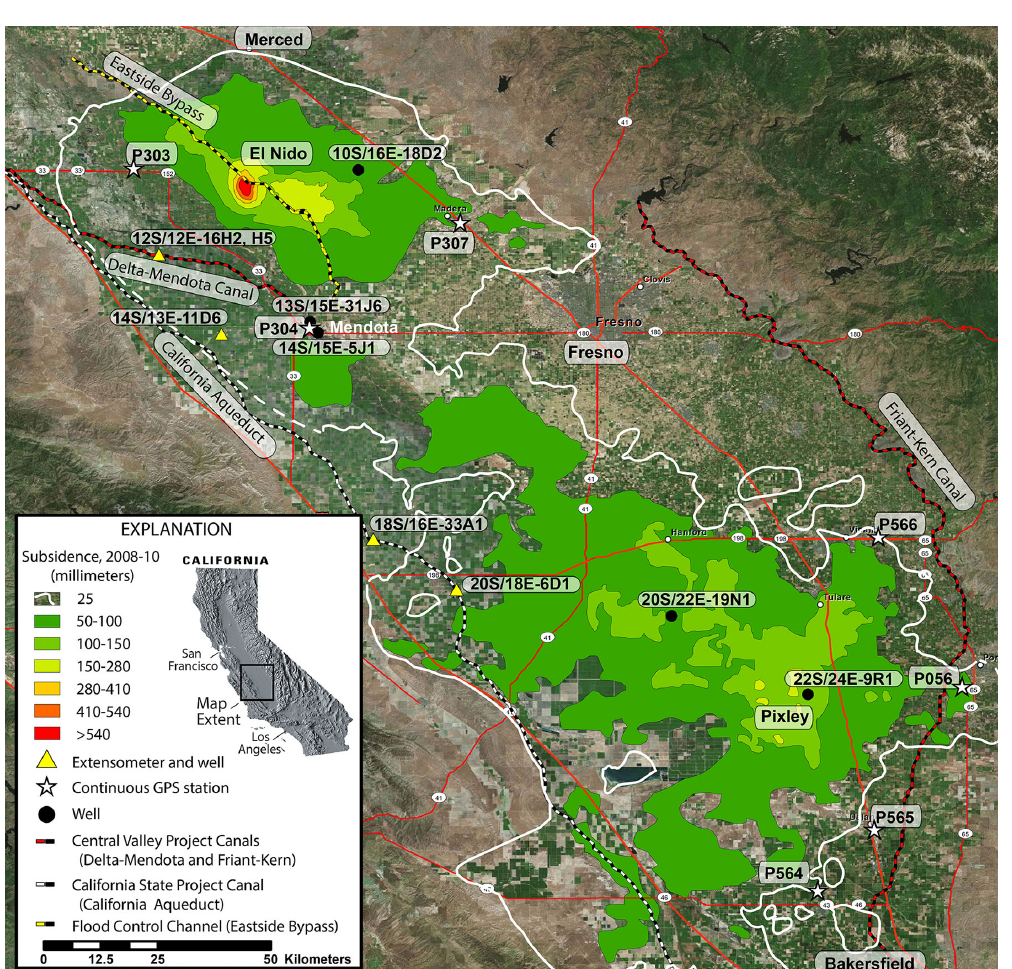
Figure 1. Map showing regions of subsidence derived from interferograms for 2008–2010, and locations of major canals, extensometers, Continuous GPS stations, and